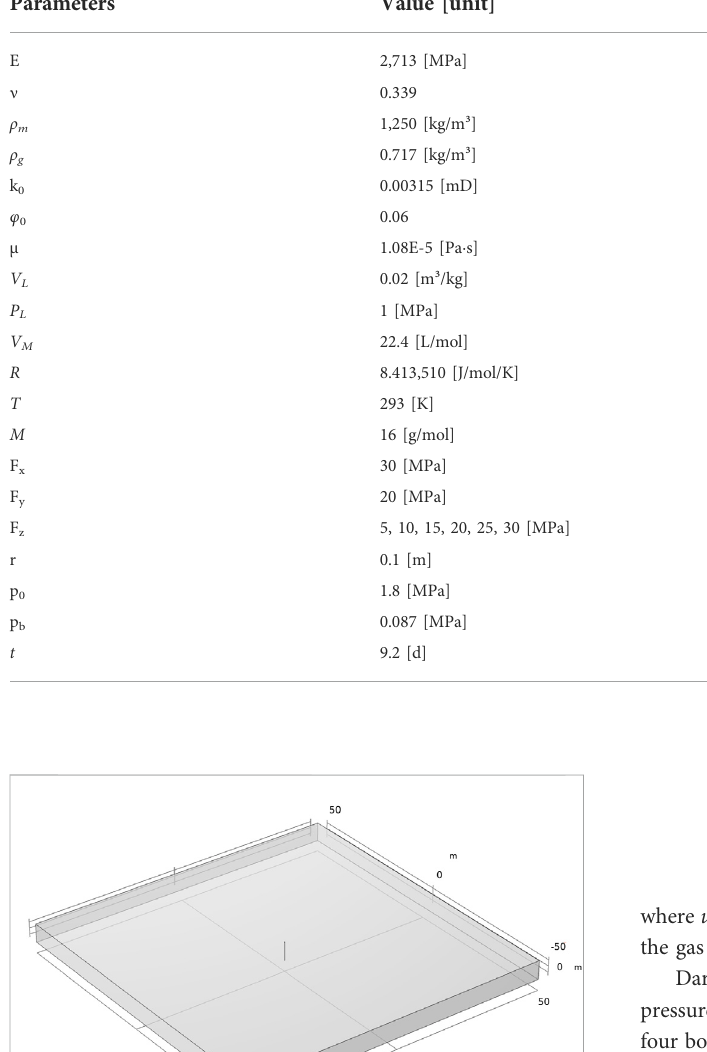
TABLE 3 Numerical simulation parameters.